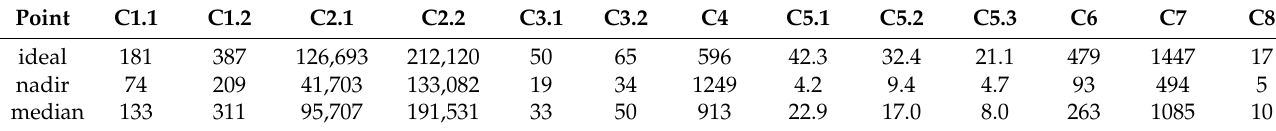
Table 6. Ideal, nadir and median criteria values for all 155,549